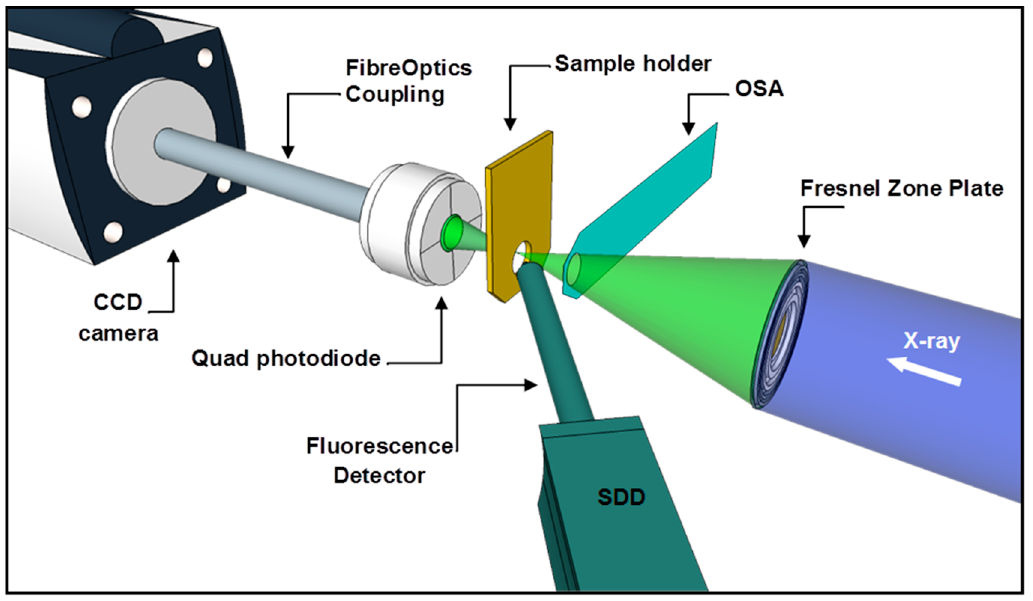
Figure 8. Schematic of SXM end-station at I08-SXM beamline. Other X-ray diffracted orders have not been shown for clarity.